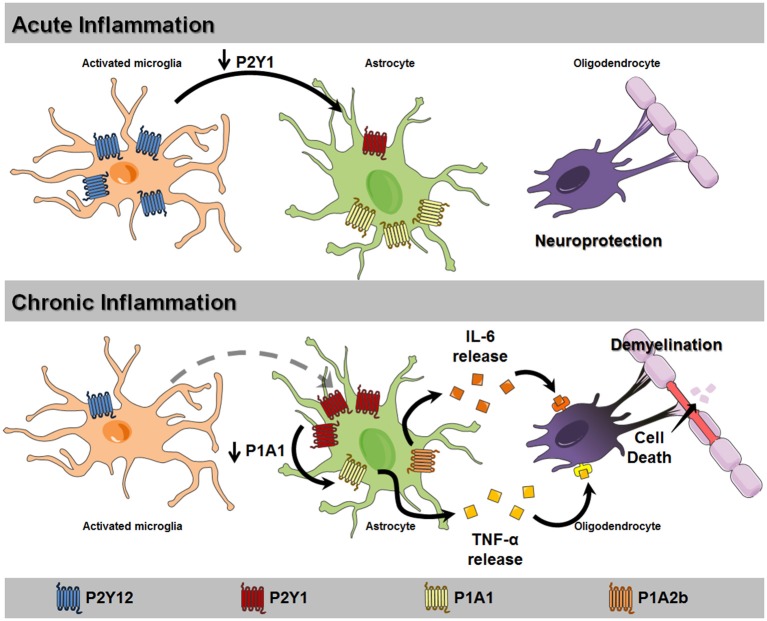
Proposed mechanism for glial purinergic dysfunction leading to loss of myelination and cell death. In acute inflammation scenarios, microglial activation upregulates P2Y12 receptor expression and activity (blue), stimulating microglial motility to the injury site. The activation of these receptors reduces P2Y1 receptor (red) expression in astrocytes, increasing reactive astrogliosis and promoting neuroprotection. Chronic inflammation, as observed in motor neuron diseases (MND), unable of upregulating microglial P2Y12 receptor expression results in constant astrocytic P2Y1 receptor activation and reduction of A1 receptor expression (yellow). These events result in stimulating tumor necrosis factor α (TNF-α) release, which in turn induces A2B receptor activation (orange) and release of IL-6. These detrimental factors induce oligodendrocyte death and neuron demyelination, aggravating the pathological scenario.